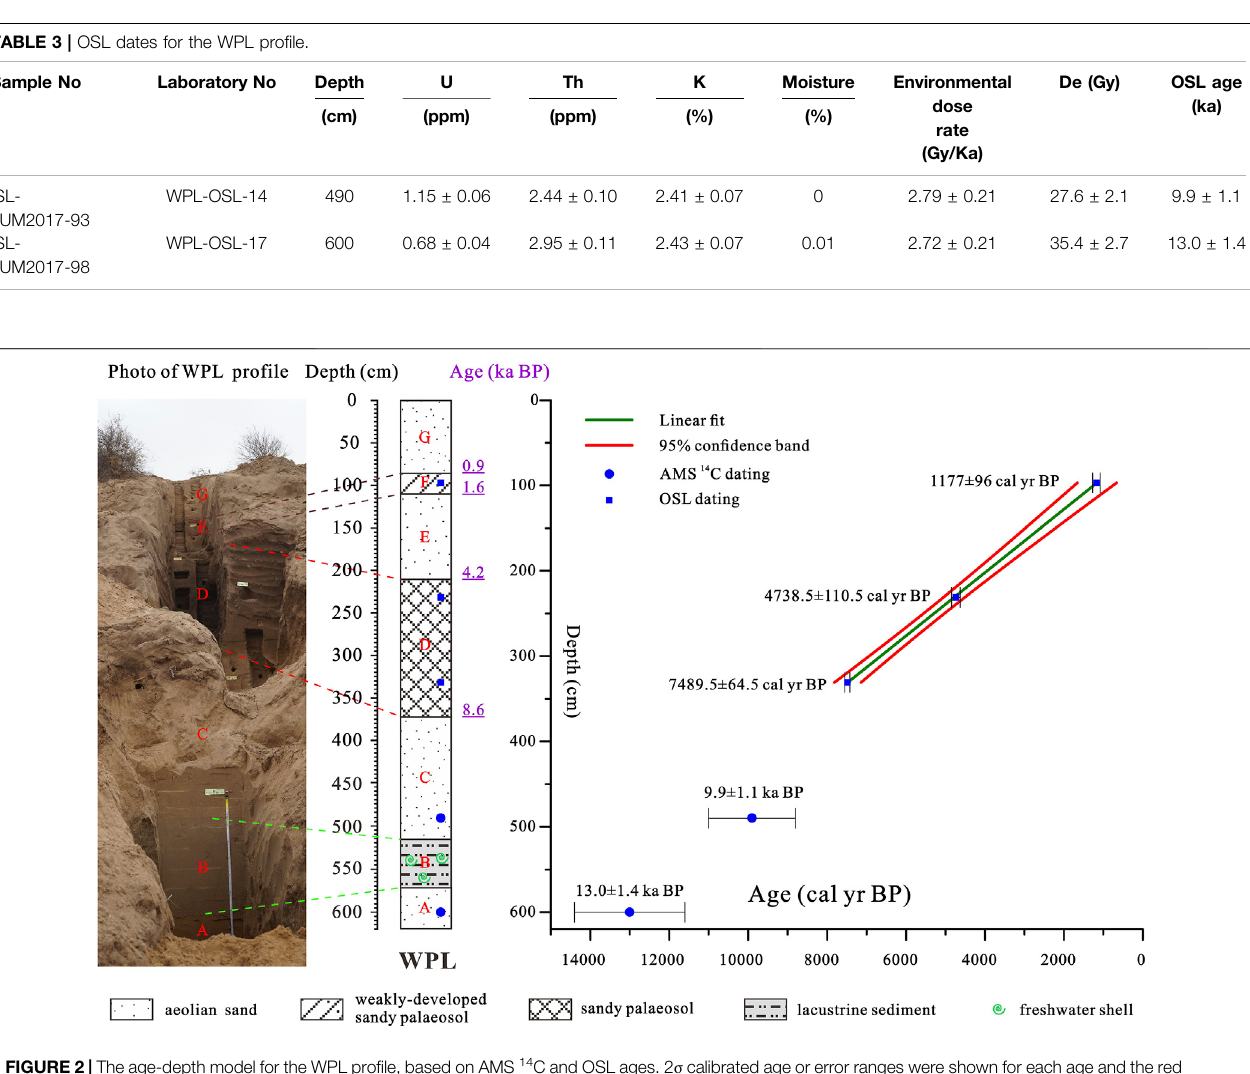
Frontiers in Earth Science |